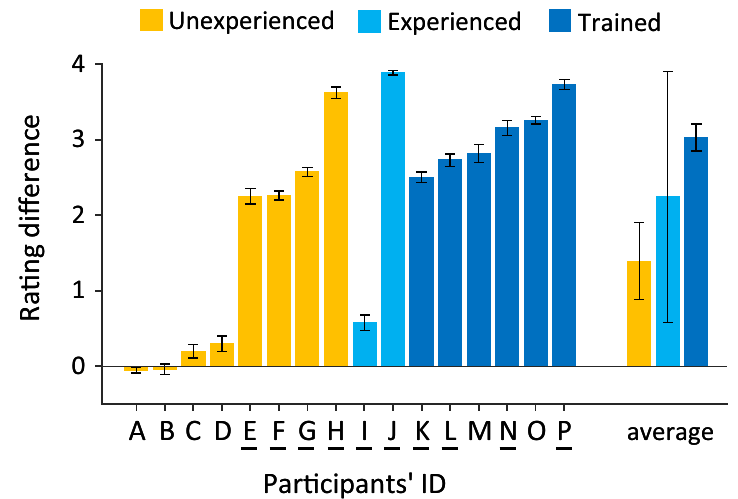
Fig 4. Rating difference and prior experience of each participant. The rating difference was averaged across all trials for each participant. Participants were classified into three group according to their prior experiences for listening to the biphasic stimuli (unexperienced, experienced, and trained; see details in Methods). Participants who had received musical practices are indicated by bars below IDs. Error bar of each participant indicates the standard error across 25 conditions (frequency × duration), and that of the group average shows the standard error across participants in that